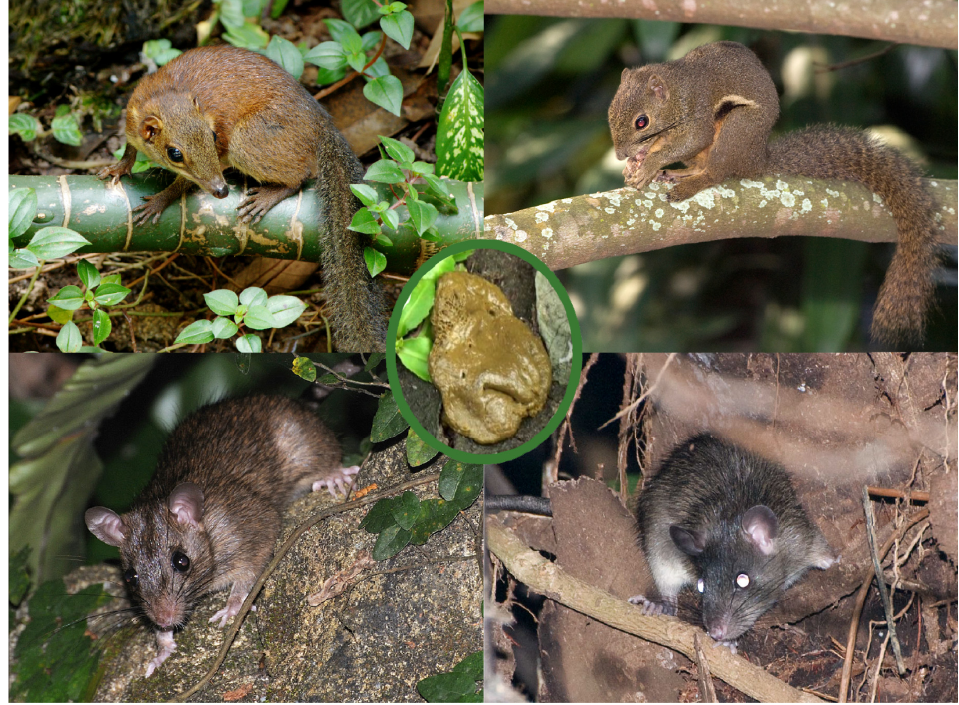
Fig 2. Species trapped in the single night of trapping in Bukit Timah Nature Reserve. Top row: T . glis (common treeshrew), C . notatus (plantain squirrel). Bottom row: R . tanezumi (Asian house rat), S . annandalei (Annandale’s rat). Photo credits : Nick Baker (mammals) and Andie Ang (fecal sample)